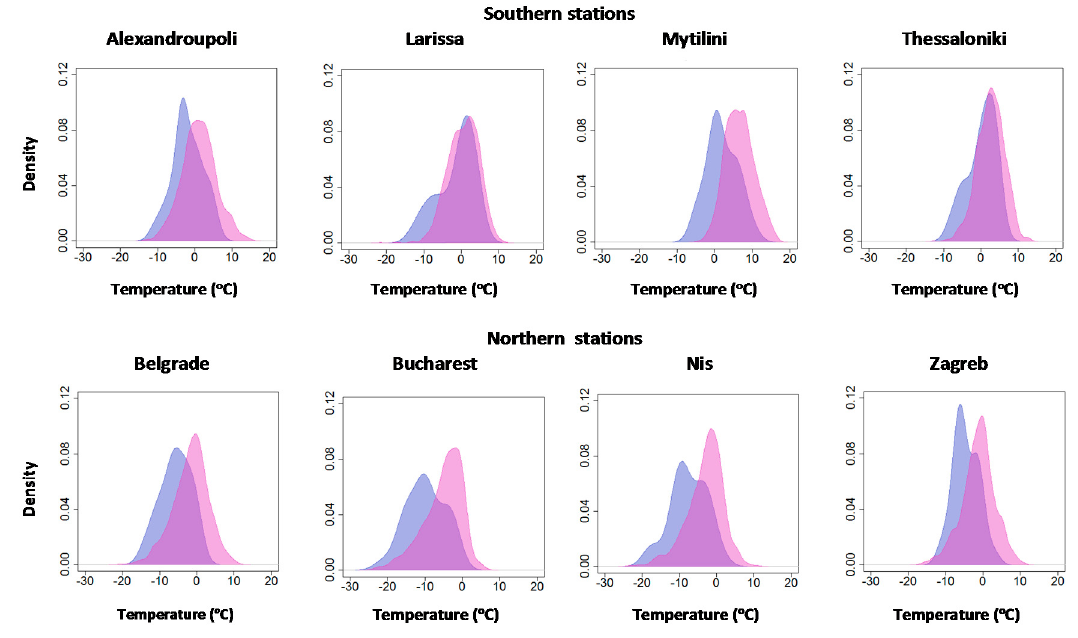
Figure 3. Density plots for the minimum temperature of January, for the reference period 1958–2012 (purple) and 2017 (light blue).